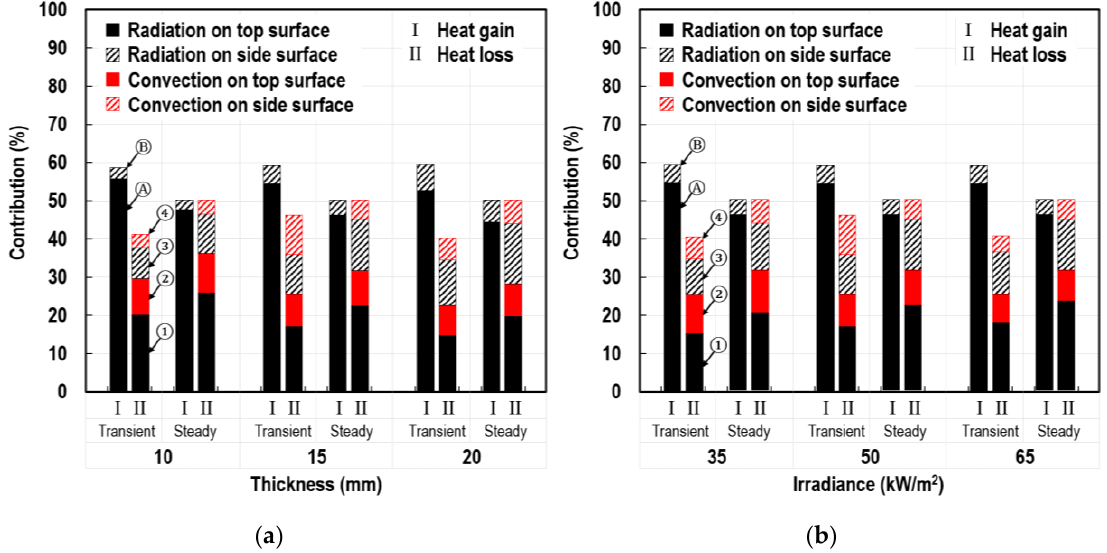
Figure 13. Individual contributions of heat transfer mechanisms during transient and steady periods at ( a ) 𝑞̇ 𝑖𝑟𝑟′′ = 50 kW/m 2 and ( b ) δ = 15 mm.